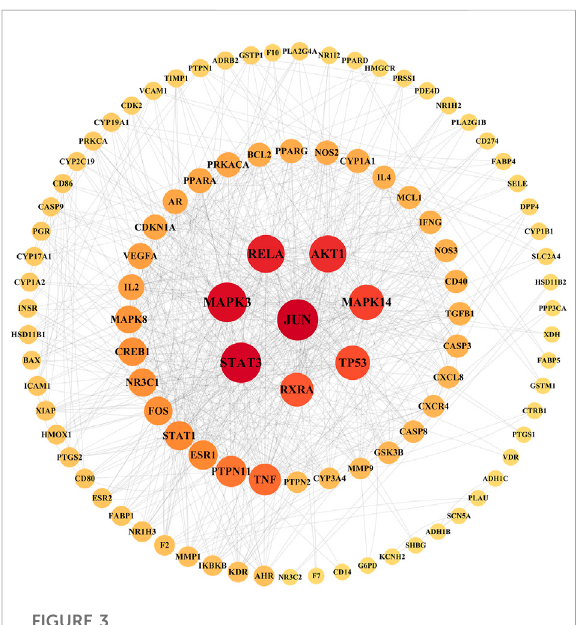
FIGURE 3 PPI network diagram of target proteins. The nodes with a larger area and darker color have a larger degree